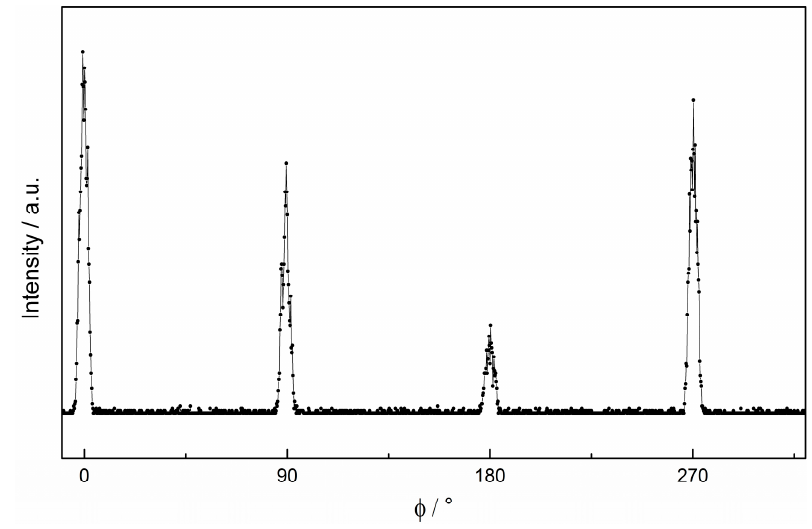
Figure 4. ɸ scan of an Ar-annealed film around the (202) reflection, showing four-fold symmetry.